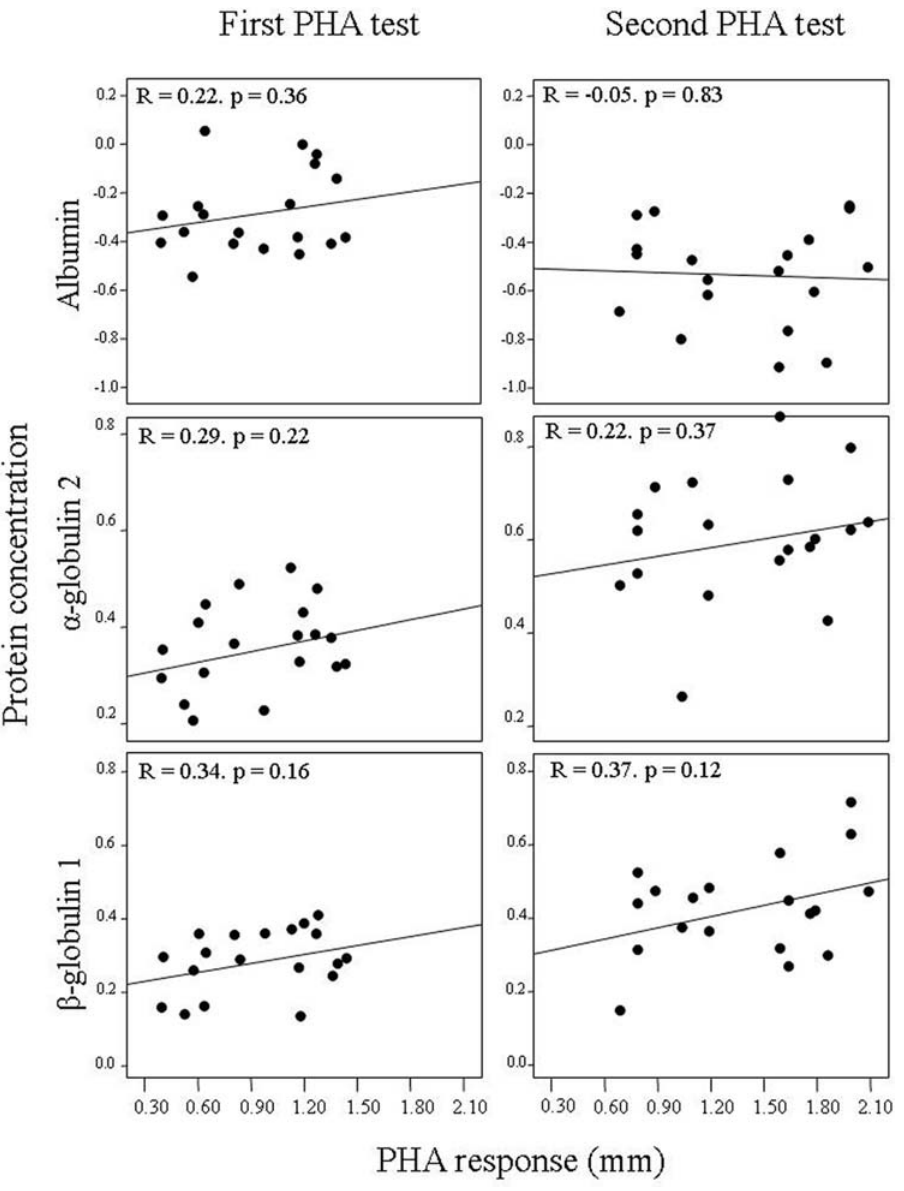
Figure 4. Relationships between local tissue swelling induced by first and second PHA injections and the concomitant changes in circulating protein concentrations ( m g/L). Regression coefficient and statistical significance are shown for each case.